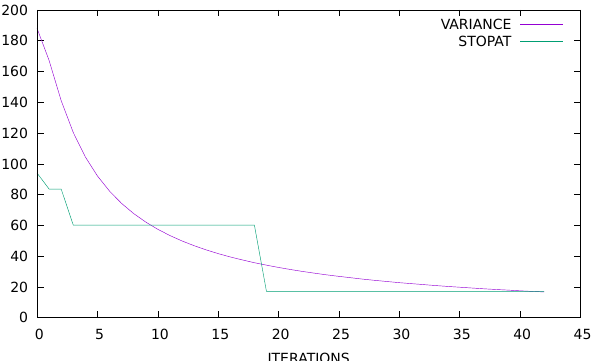
Figure 2. Plot of the used termination rule for the EXP8 test